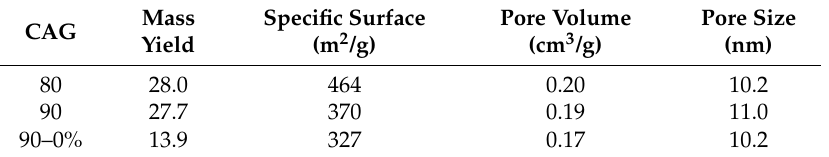
Figure 2. Effect of dwell time and temperature on morphology of carbon aerogels (CAGs). ( a ) Specific surface area, ( b ) pore volume. Heating rate: 10 °C/min.